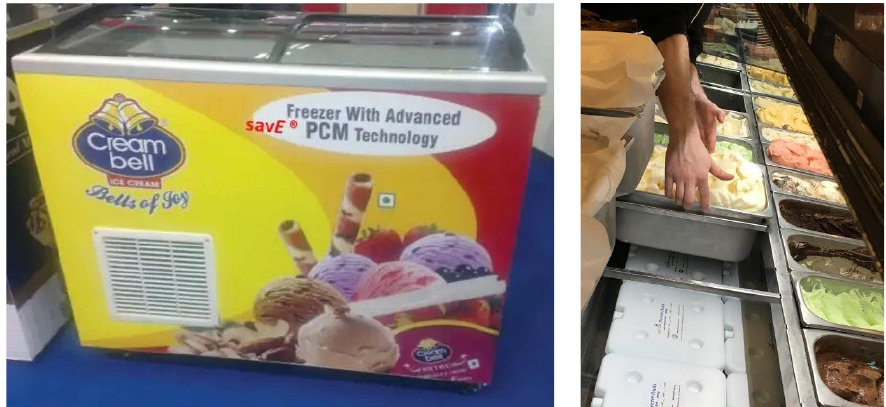
Figure 9. Display/retail freezer/cooler (source: PLUSS Advanced Technologies Ltd.) and PCM-based cold battery as thermal backup for retail freezers (source: RGEES).